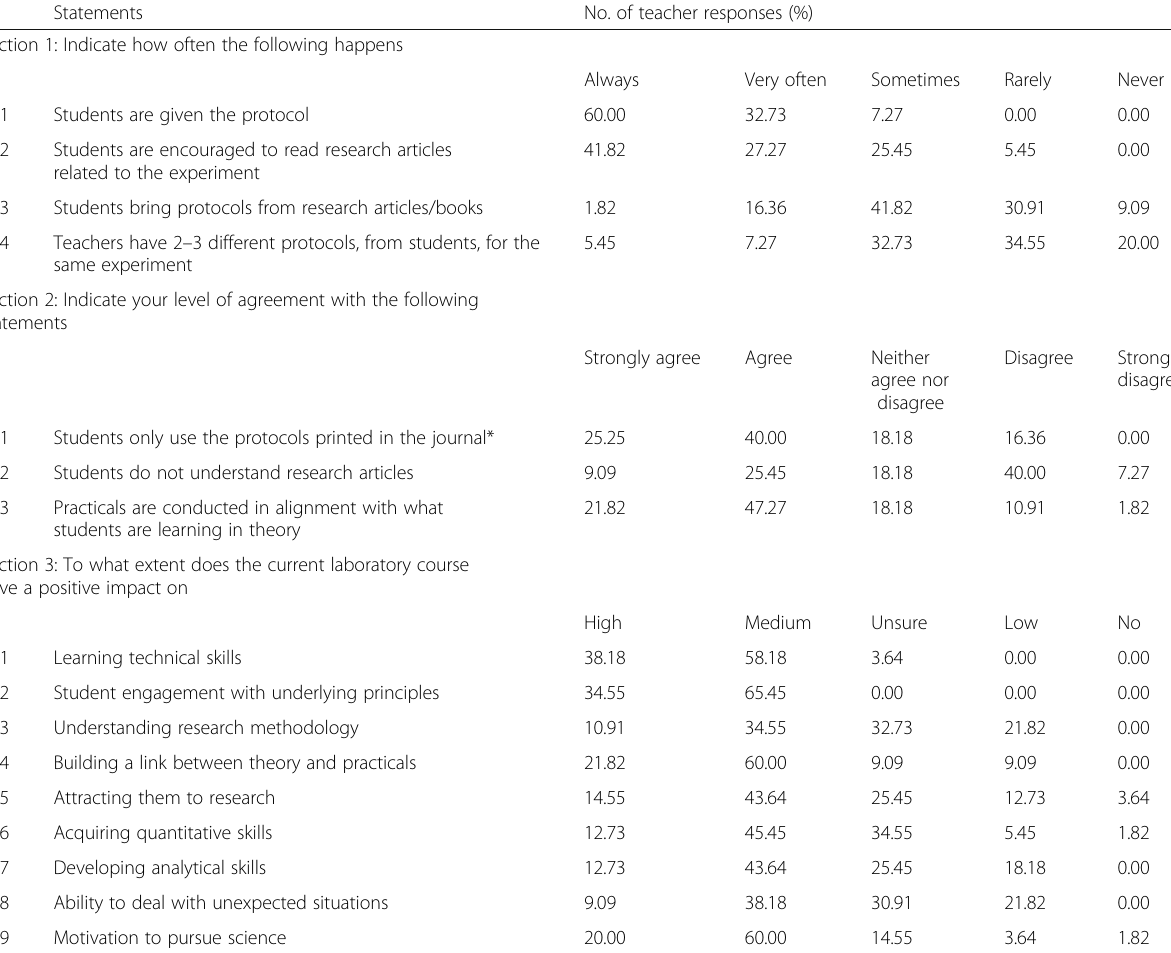
Table 5 Teachers ’ (group 4, n = 55) responses to the questionnaire on their practices and the effectiveness of the laboratory